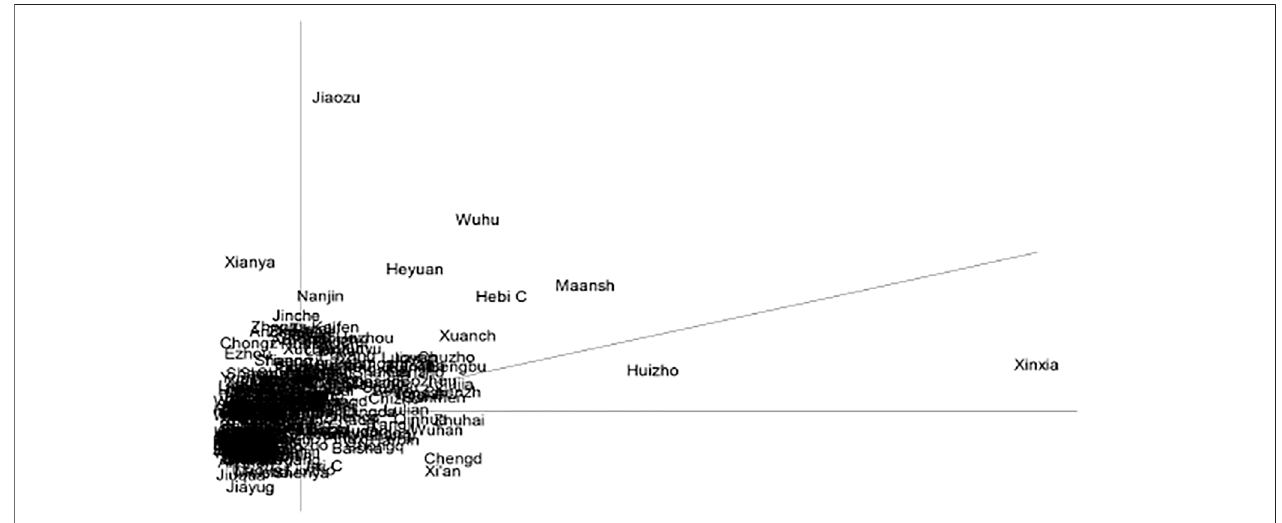
FIGURE 3 | The Moran Index of green invention patents in 2018.